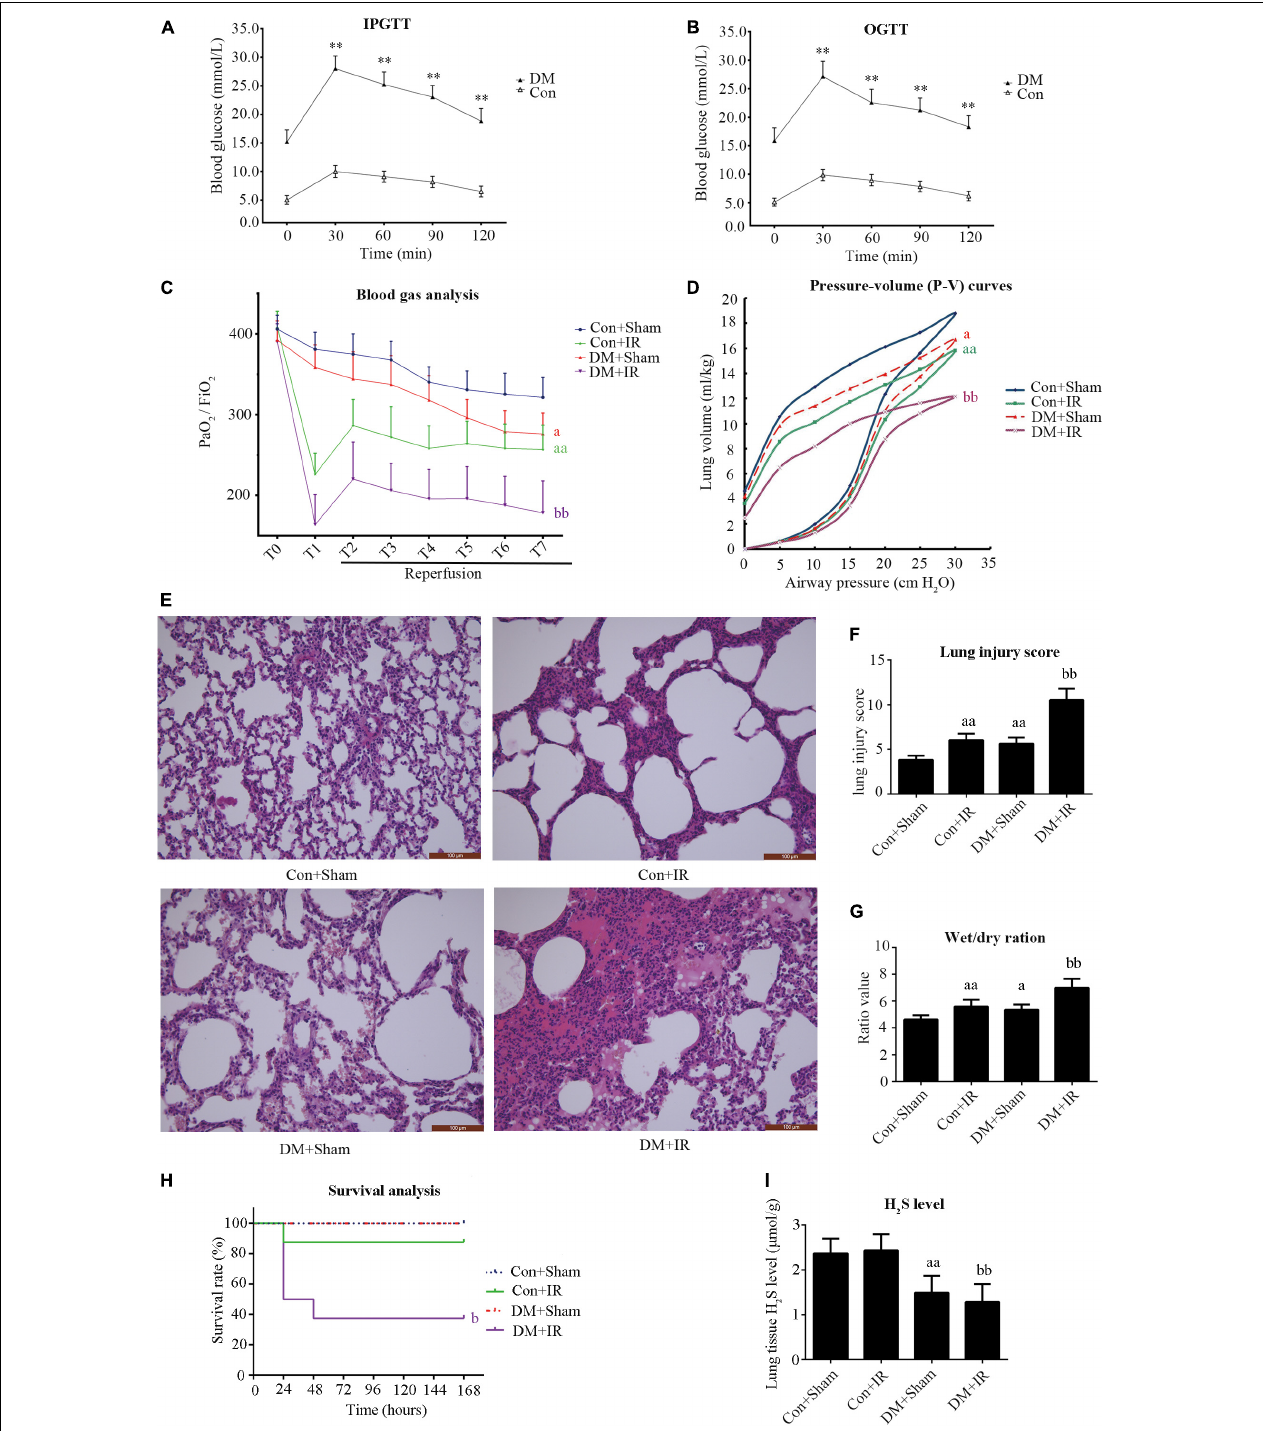
FIGURE 1 | Type 2 diabetic rats subjected to lung IR injury exhibited significantly impaired lung function. (A) IPGTT, intraperitoneal glucose tolerance test. (B) OGTT, oral glucose tolerance test. (C) Arterial blood gas analysis. T0–T7 represent the following time points: baseline, end of ischemia, and 30, 60, 90, 120, 180, and 240 min after reperfusion. (D) Static compliance of the lung pressure–volume (P–V) curves. Data are represented by the mean values, and the bars are omitted for clarity. (E) Histologic analysis of lung tissues (magnification: 200 × ). (F) Lung injury score. (G) Wet/dry weight ratio. (H) Survival analysis. Rats were observed for 168 h (1 week), and survival time was calculated. (I) Lung H 2 S levels in rat. PaO 2 /FiO 2 : partial pressure of arterial oxygen (PaO 2 )/fraction of inspired oxygen (FiO 2 ). IR, ischemia-reperfusion; DM, diabetes mellitus (** P < 0.01 versus Con group, a P < 0.05 versus Con + sham group/ aa P < 0.01 versus Con + sham group, b P < 0.05 versus Con + IR group/ bb P < 0.01 versus Con + IR group; n = 8 in each group).